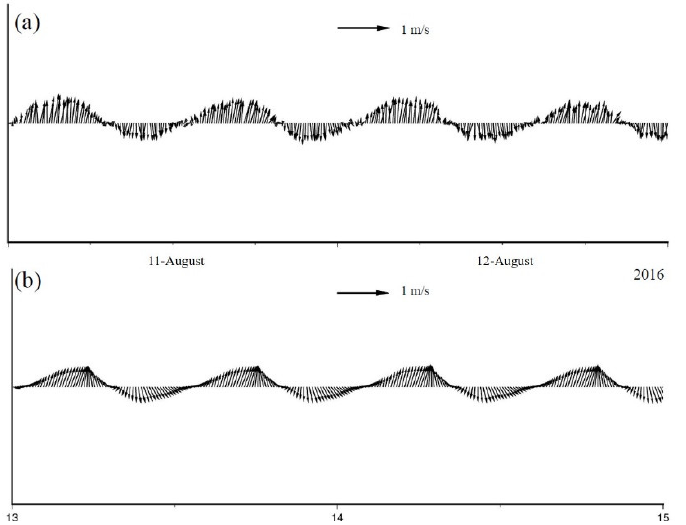
Figure 11. ( a ) The observed current flow on 11–12 August 2016 at the ADCP current station ( b ) The modeled velocity equivalent to the current meter location agrees well with the observed current.